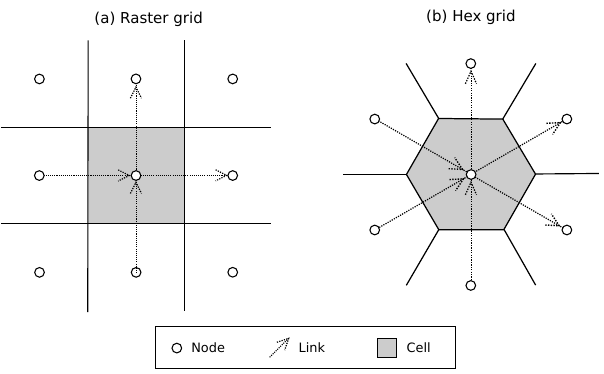
Figure 3. Schematic illustration of CellLab-CTS grid types and ge- ometric primitives. (a) Regular (raster). (b) Trigonal lattice with hexagonal cells. Note that standard link orientation is within the x ≥ y half plane; in other words, the angle of a link, θ , with respect to the positive x axis is always − 45 ◦ ≤ θ ≤ 135 ◦ .